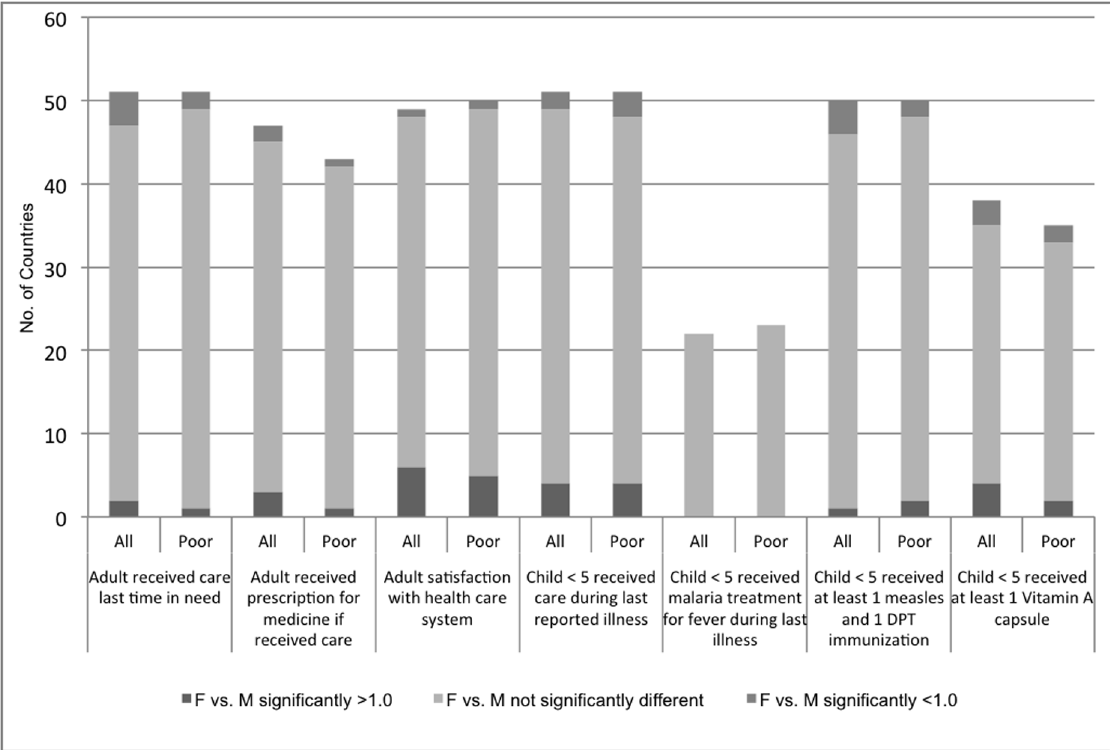
Figure 4. Access to care, number of countries with significant gender differences, all versus poor households.